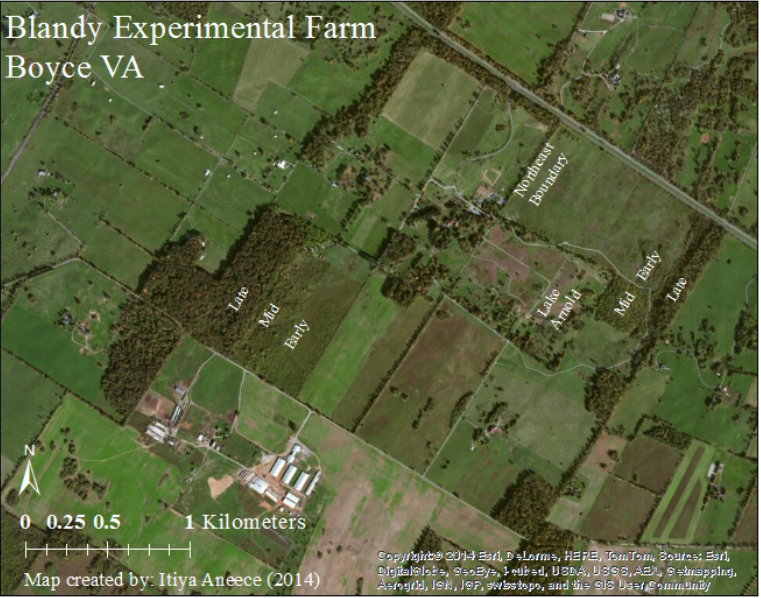
Figure 1. Blandy Experimental Farm, Boyce VA with study site labels including two secondary successional